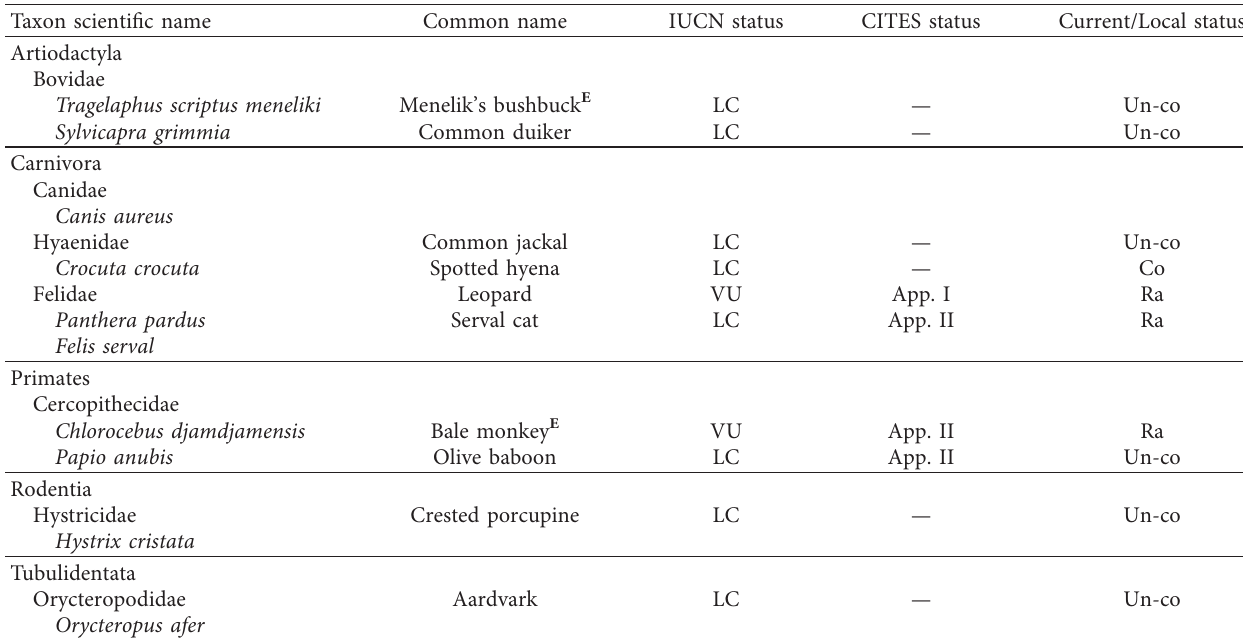
Table 1: Checklist of large wild mammals registered in Geremba Mountain, southern Ethiopia.